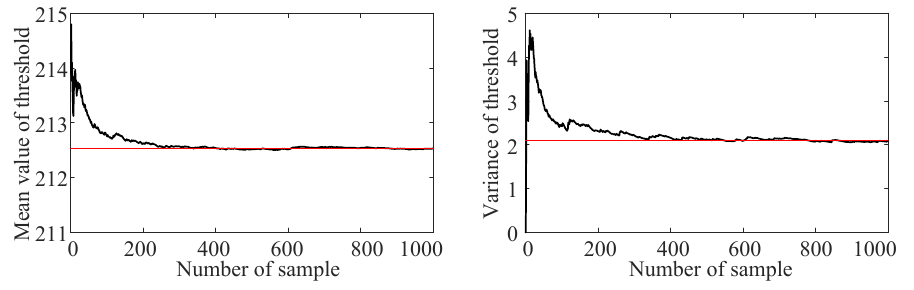
Figure 7. Convergence of MC simulation.